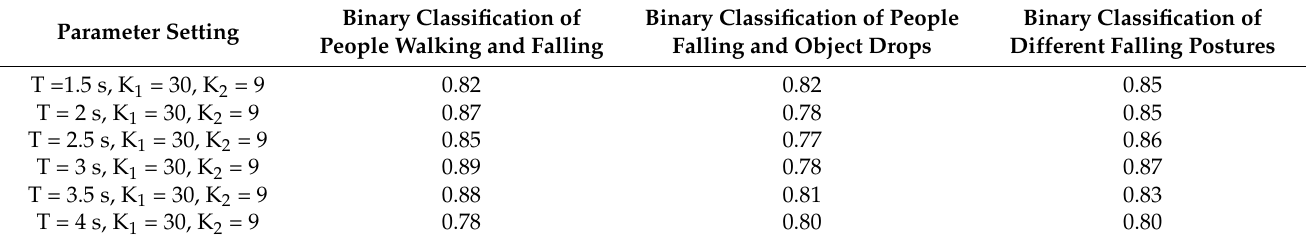
Table 1. Accuracy of classification with different T values.